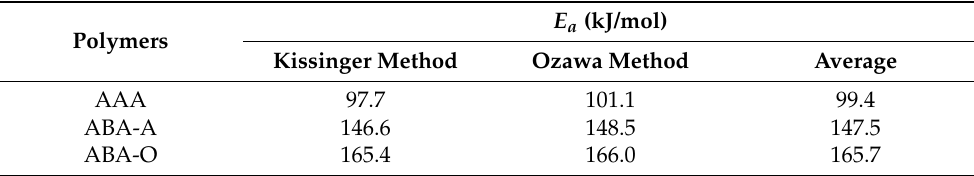
Table 5. The apparent activation energies for the curing reactions of three polymers.